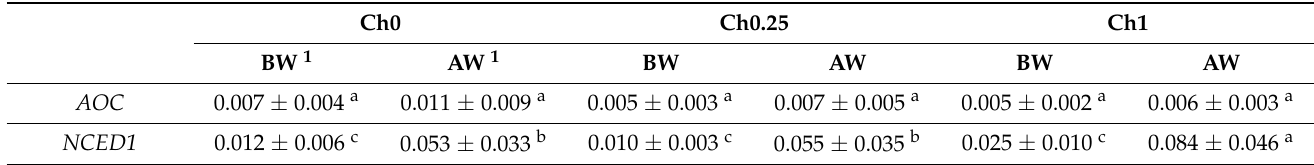
Table 1. Changes in transcript level of Allene Oxide Cyclase and 9-Cis-Epoxycarotenoid Dioxygenase in roots after foliar application of chitosan and wounding for 30 min. Means ± SD, n = 4. NS means non-significant differences between treatments while different letters indicate significant differences between treatments following two-way ANOVA (Duncan’s multiple range, p ≤ 0.05).